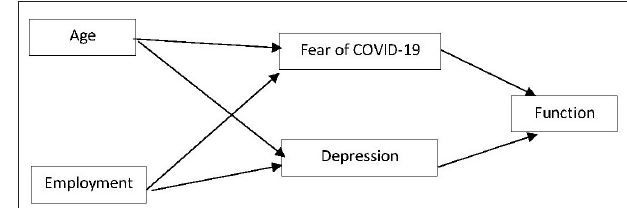
FIGURE 1 | Theoretical model for predicting function during COVID-19